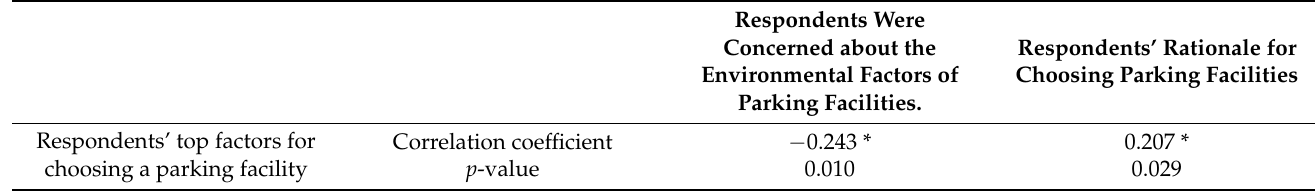
Table 7. Results of an analysis of drivers’ factors in choosing parking facilities.